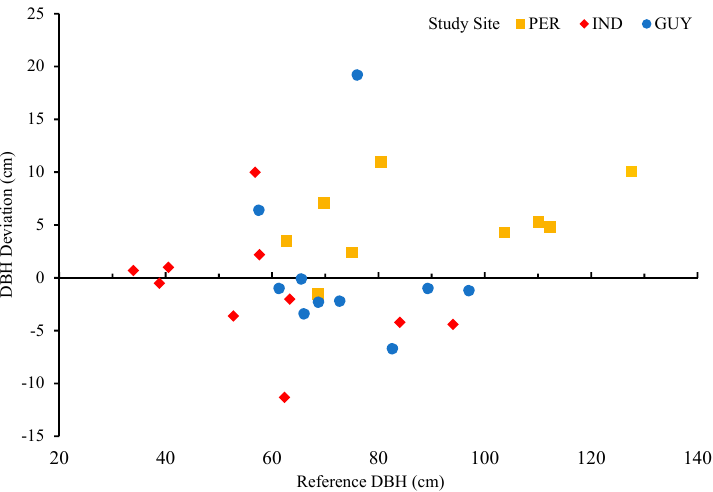
Figure 15. DBH deviation for each sample.